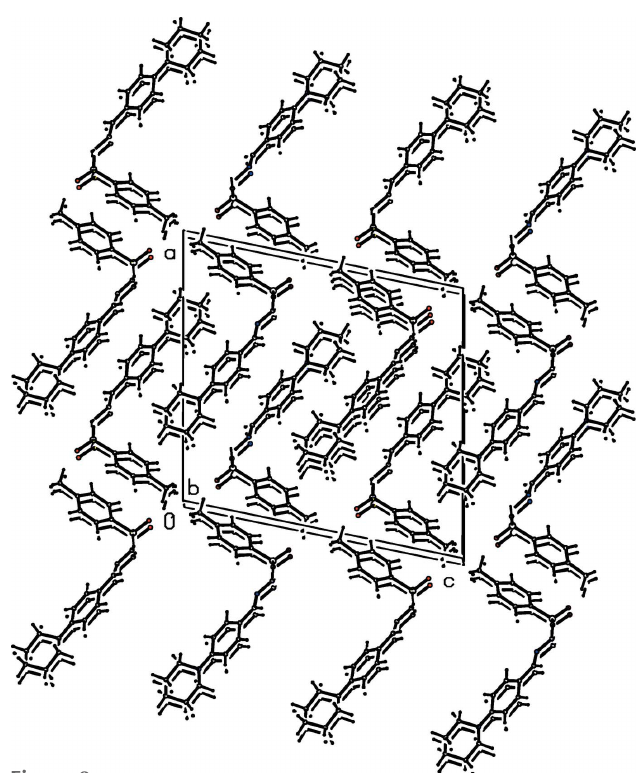
Figure 8 Molecular packing of (II).